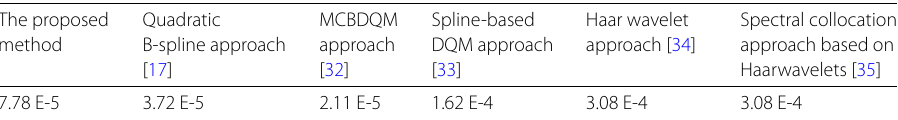
Table 5 The maximum absolute error The proposed method